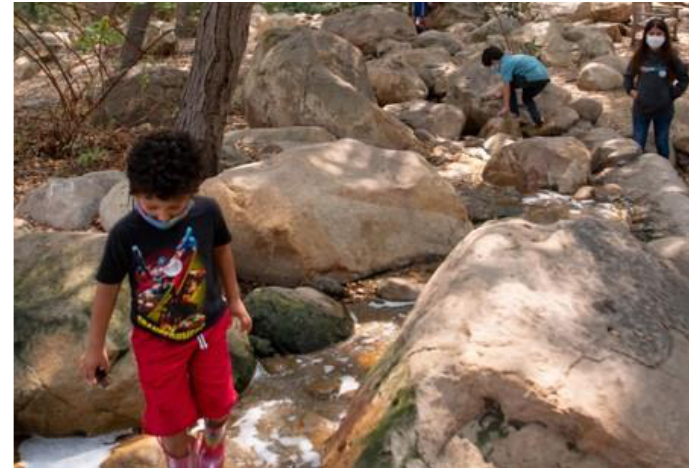
Figure 4. Upper creek area.